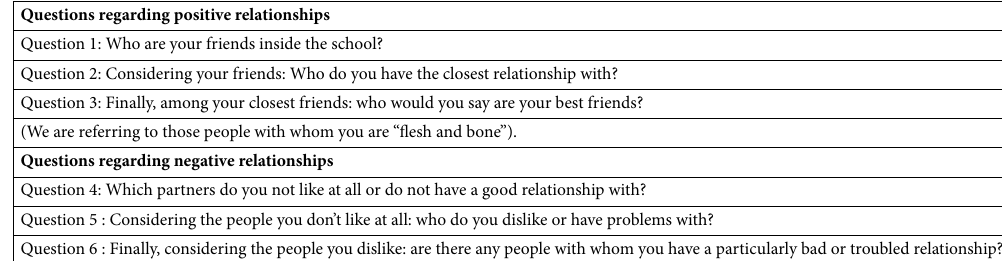
Table 1. Questionnaire for positive and negative relationships. Students could choose names among all other students in their year, by clicking on each of the